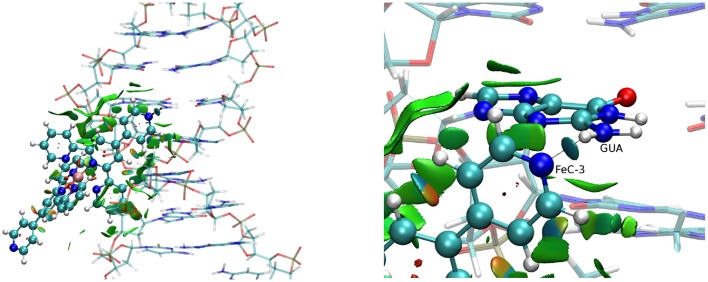
NCI cartoons for the FeC-3 (poly(dG)-poly(dC)) strand (left) and a zoom showing the interaction with guanine (right).